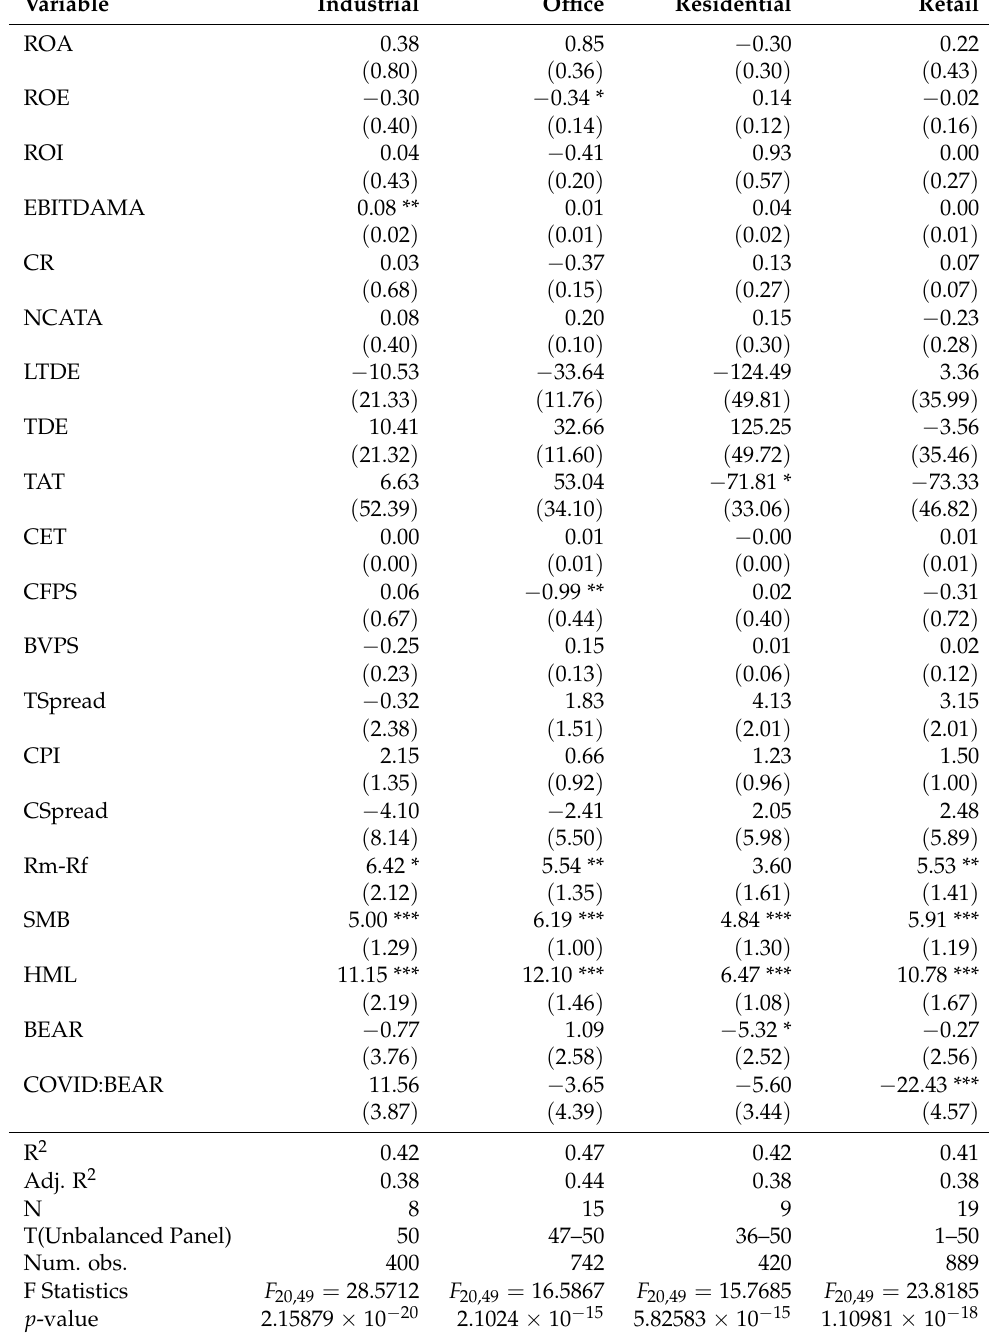
Table A7. Model Result—Specification